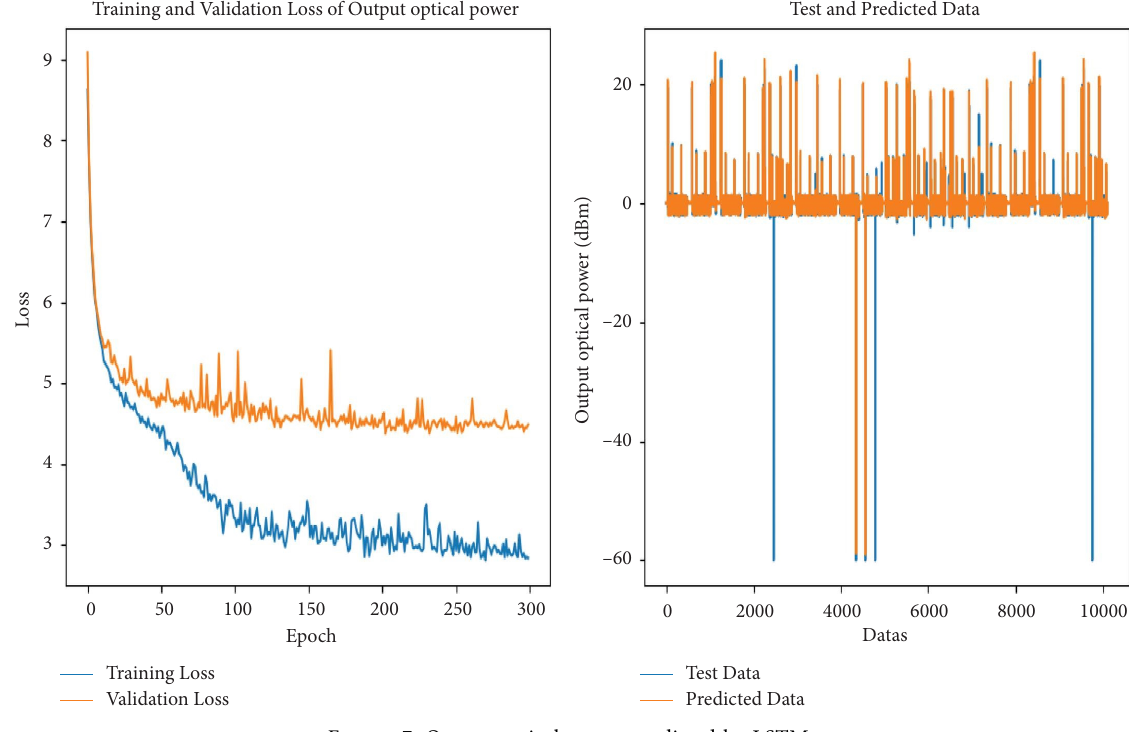
Figure 7: Output optical power predicted by LSTM.